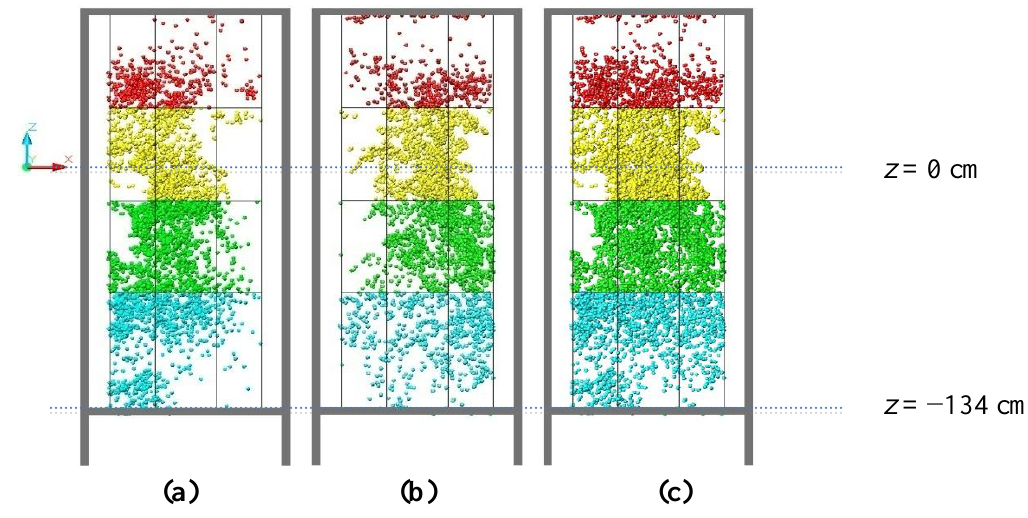
Figure 16. Left-hand side view of the reference structure and point cloud obtained from the rear view scan R-05A-05S (a) , front view scan F-05A-05S (b) and the two scans combined ( c ). The height position of the sensor is always 0 ( z = 0).